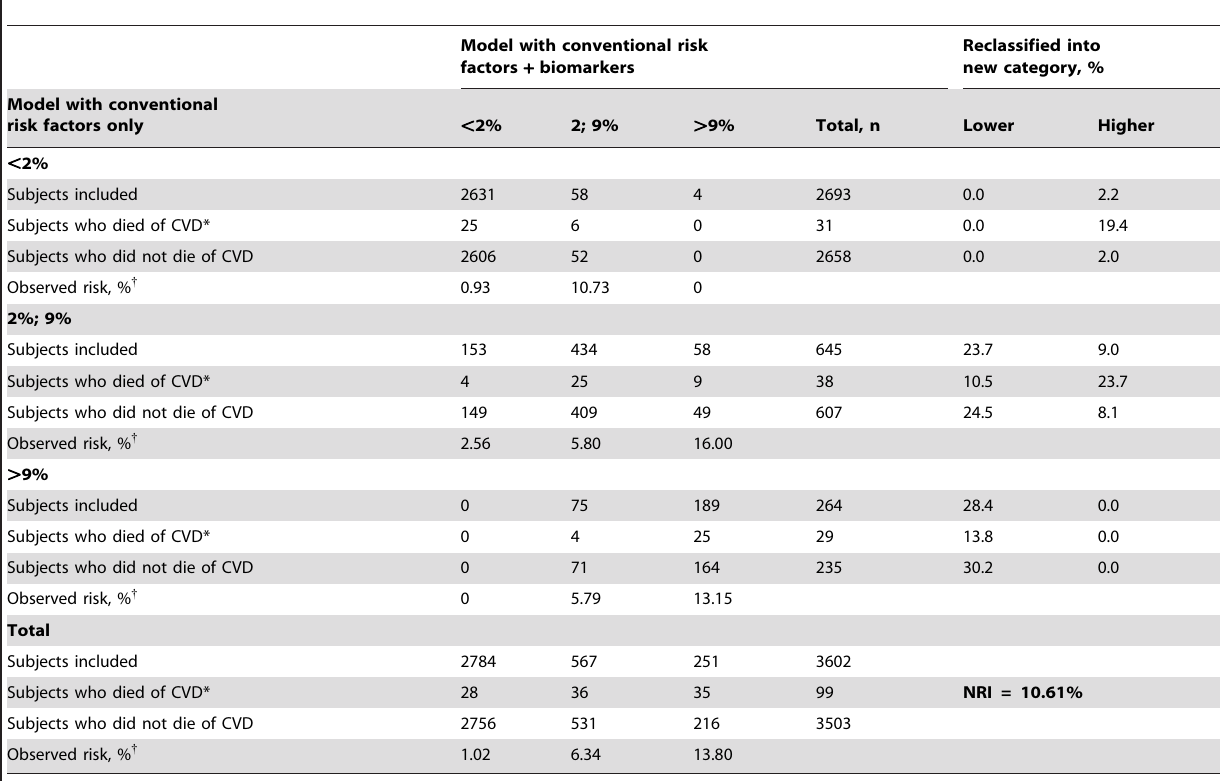
Table 8. Reclassification of cardiovascular deaths using the model with both conventional cardiovascular risk factors and biomarkers retained after